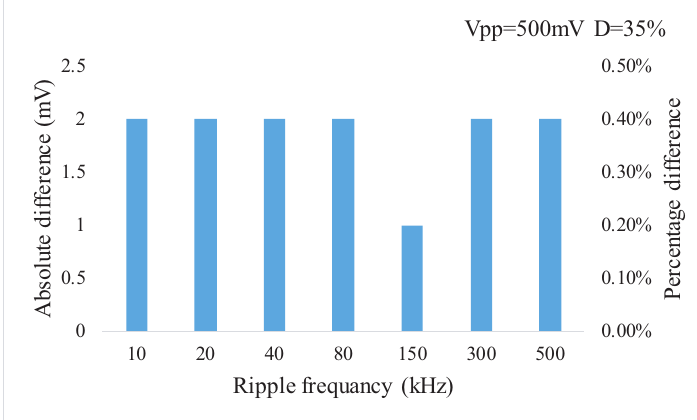
Figure 12. The measurement differences for different